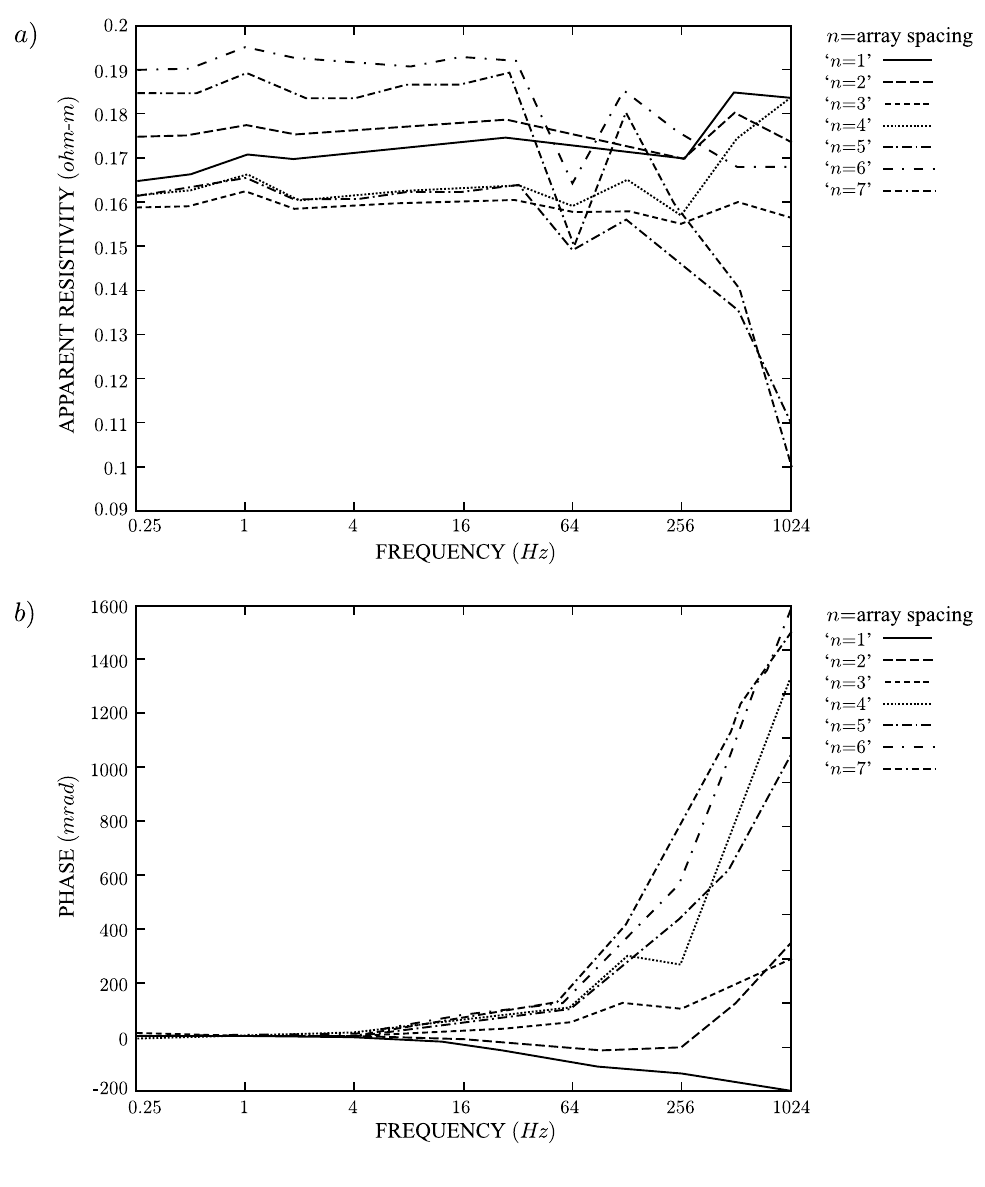
Fig. 5 – Behavior of (a) the amplitude and (b) the phase of the apparent resistivity on the sea surface, for the seven array spacing of investigation, and for the bar electrode (0.10